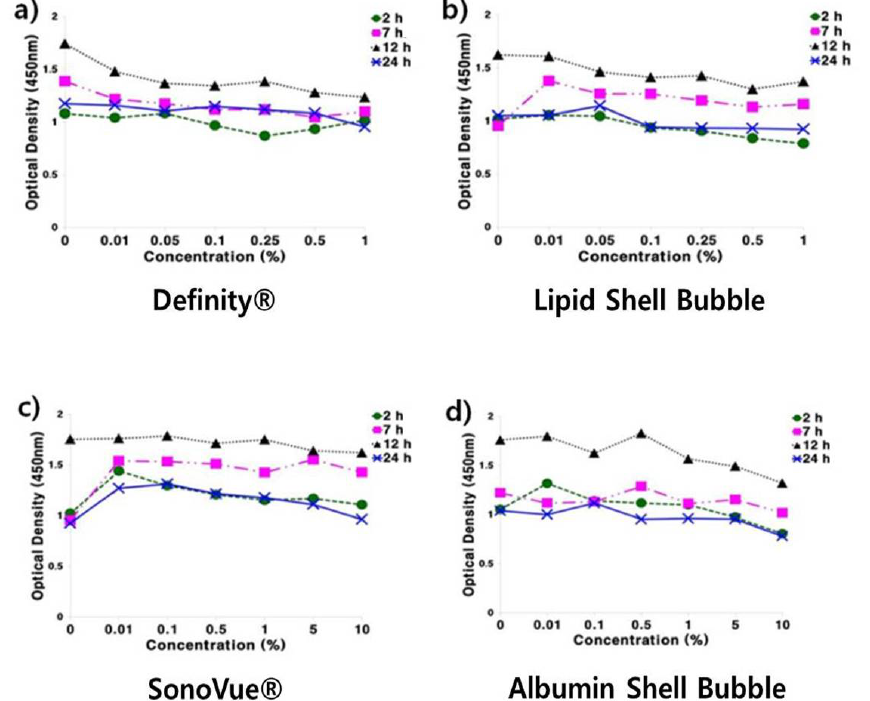
are not toxic to 293A human embryo kidney